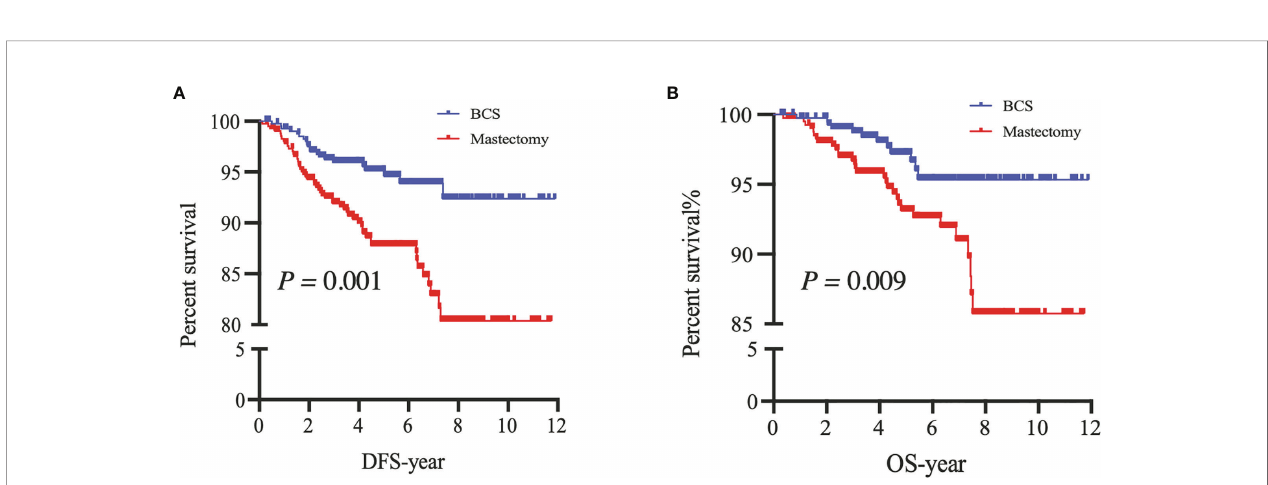
FIGURE 3 | Disease-free survival (DFS) of patients among the three surgical options (A) and overall survival (OS) of patients among the three surgical options (B) . BCS, breast-conserving surgery; Mastectomy, mastectomy alone; Reconstruction, mastectomy